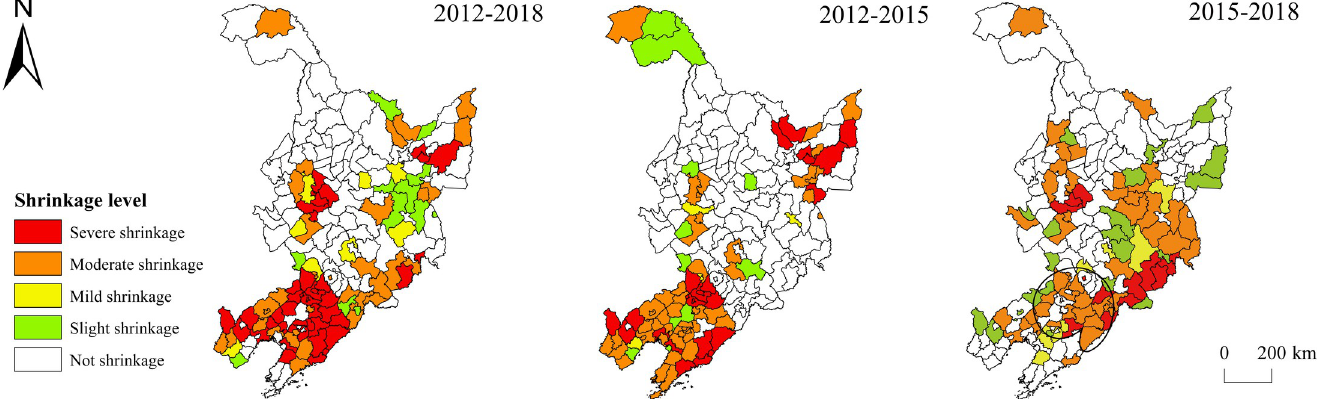
Fig 4. Spatial difference of economy-related shrinkage of the three northeastern provinces. Note: The basic map came from a public map from the standard map service website of the Ministry of Natural Resources of China. The drawing approval number is GS (2016)1593.